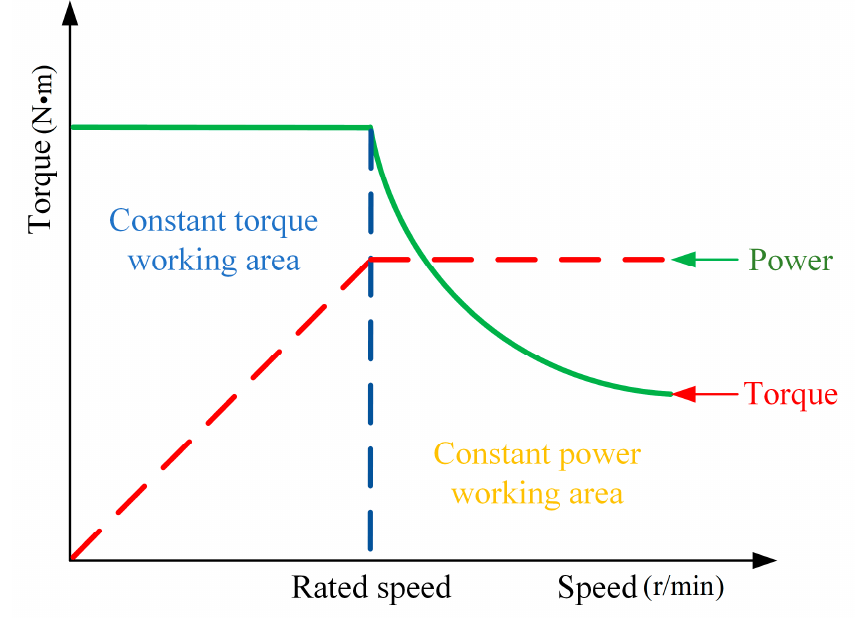
Figure 3. Motor external characteristic curve.